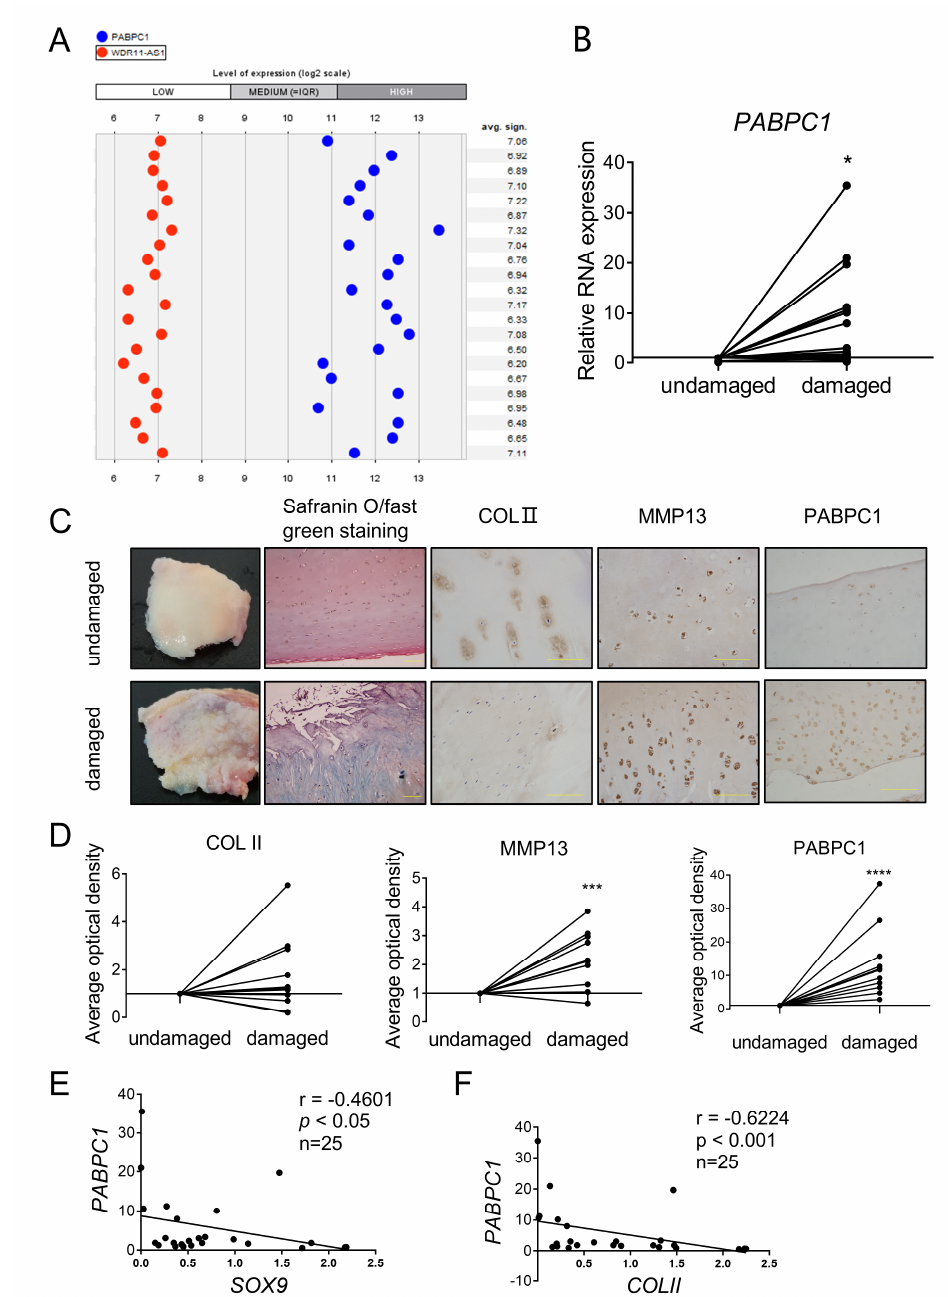
Figure 5. High expression of PABPC1 in OA cartilage tissues. ( A ) Expression levels of PABPC1 and WDR11-AS1 in human osteoarthritic cartilage compared with nonosteoarthritic cartilage data from the Genevestigator database (E-MTAB-4304, E-MTAB-6266, E-MTAB-7313, GSE117999, GSE114007, GSE110606). ( B ) PABPC1 mRNA levels were determined by RT-qPCR in cartilage tissues of undam- aged and damaged regions in OA patients; n = 25. ( C ) Representative photographs of Safranin O/Fast Green staining and immunohistochemistry for COLII, MMP13, PABPC1; 200× magnification; scale bars, 100 μm. ( D ) Quantification of the immunohistochemistry for COLII ( n = 11), MMP13 ( n = 10), and PABPC1 ( n = 11). ( E ) The correlation between SOX9 mRNA and PABPC1 mRNA in OA patients was determined by Spearman correlation analysis. ( F ) The correlation between COLII mRNA and PABPC1 mRNA in OA patients was determined by Spearman correlation analysis. * p < 0.05, *** p < 0.001, **** p < 0.0001, damaged vs. undamaged ( B , D ). Data were compared using paired t -tests.